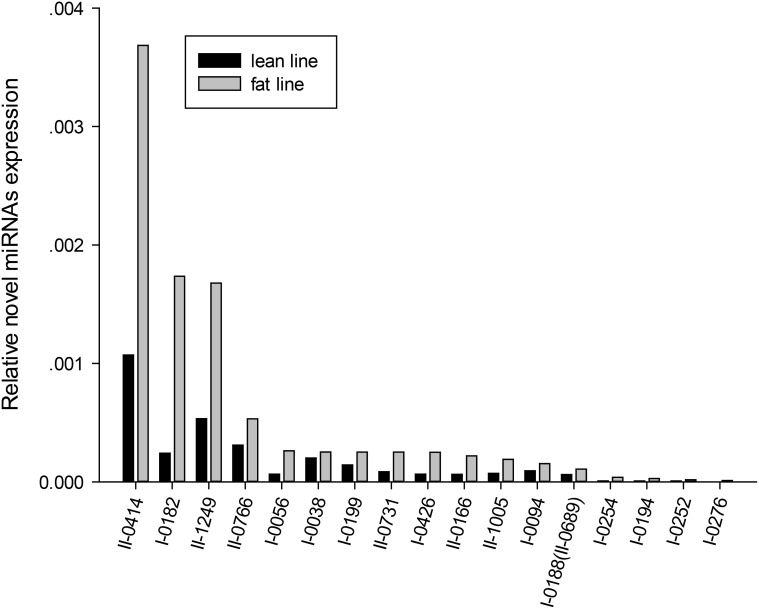
Expression validation of 17 novel miRNAs.Novel miRNAs have relative low expression levels, consistent with their low read numbers by Illumina sequencing.